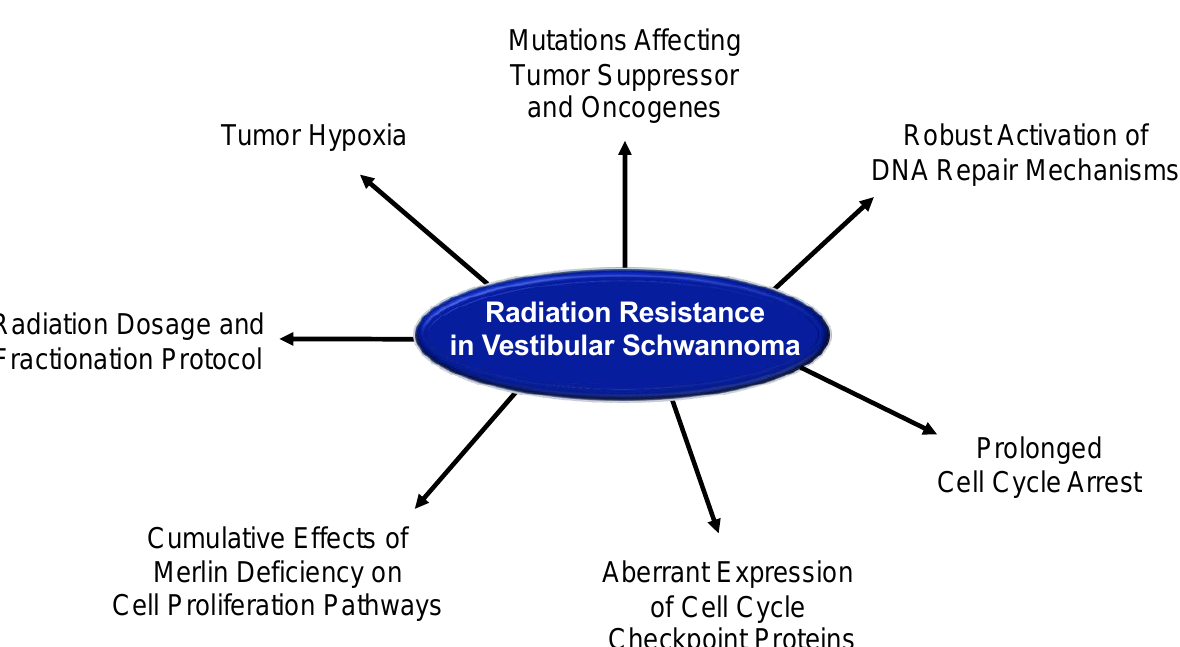
Figure 6. Potential mechanisms of radiation resistance in vestibular schwannomas. Radiation resistance may develop as a result of tumor hypoxia, mutations affecting tumor suppressor and oncogenes, robust activation of DNA repair mechanisms, prolonged cell cycle arrest, aberrant expression of cell cycle checkpoint proteins, cumulative effects of merlin deficiency on cell proliferation pathways, and/or radiation dosage and fractionation protocol